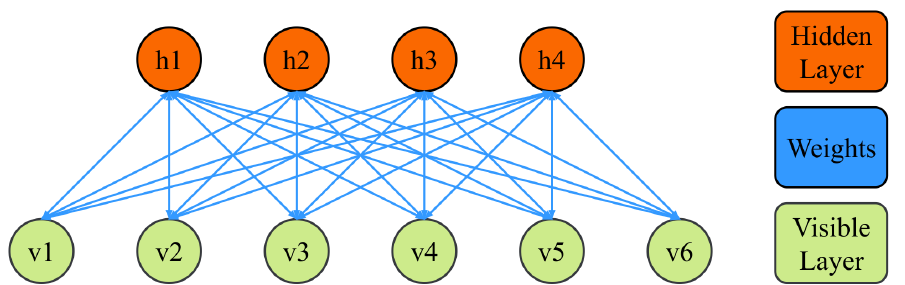
Figure 3. The structure of the restricted Boltzmann